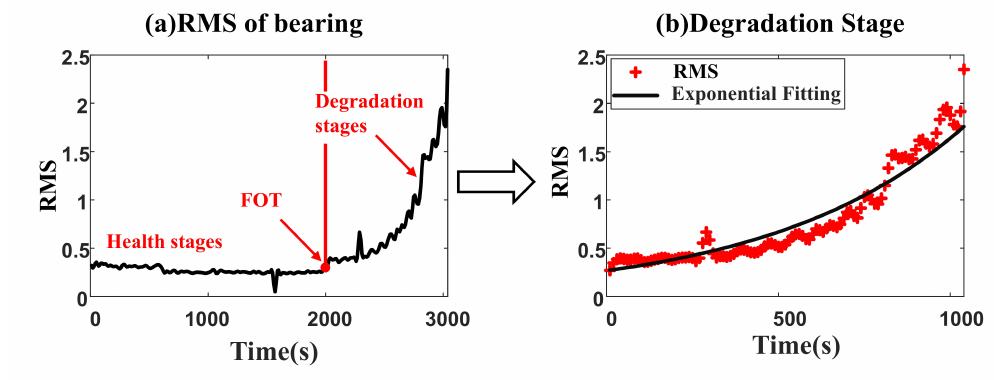
Figure 2. ( a ) The RMS of the whole life data of bearing ( b ) Degradation model fitting of the degra- dation stage. Two stages are included in the run-to-failure data of bearing. The RMS of the bearing shows a steady state in the health stage. After Failure Occurrence Time (FOT), the RMS of the bearing shows an exponential degradation in the degradation